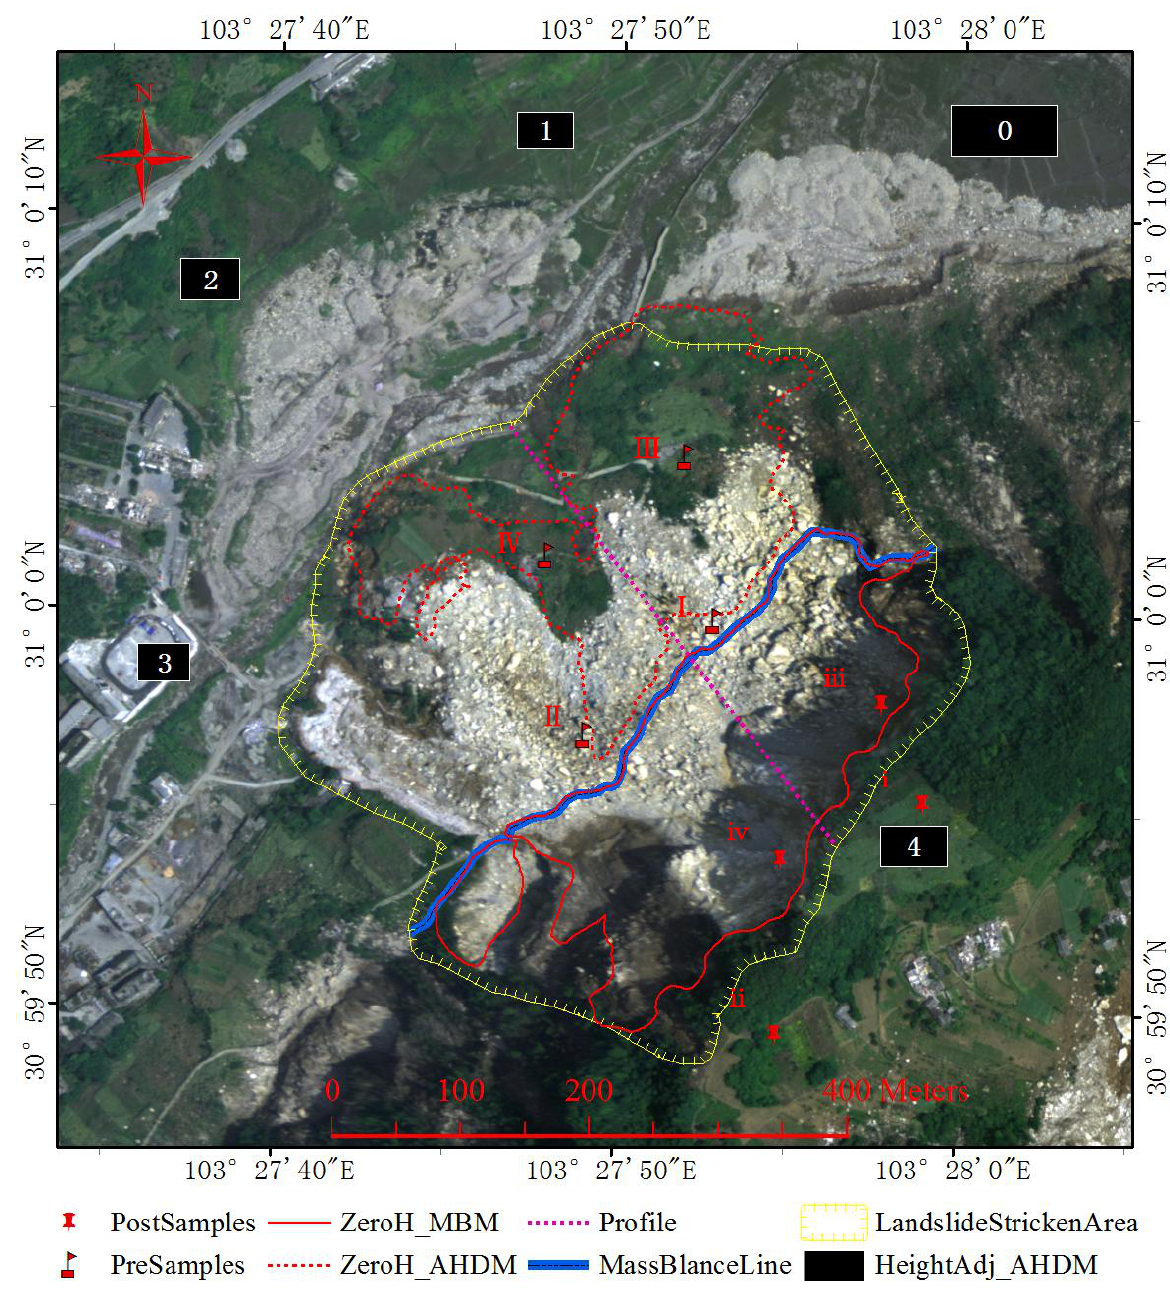
Figure 5. Detailed image of the tested landslide. The landslide lies within the yellow line. The red flags and markers are the points where the field samples were taken. The black rectangular boxes are the height adjustment sub-areas used by AHDM. The red dotted line is the contour line where the elevation difference is zero according to AHDM. The red line is the contour line marking zero elevation difference according to MBM. The pink dotted line is the location of the profile which is shown in Section 3.3.2. The blue thick line is the mass balance line derived using